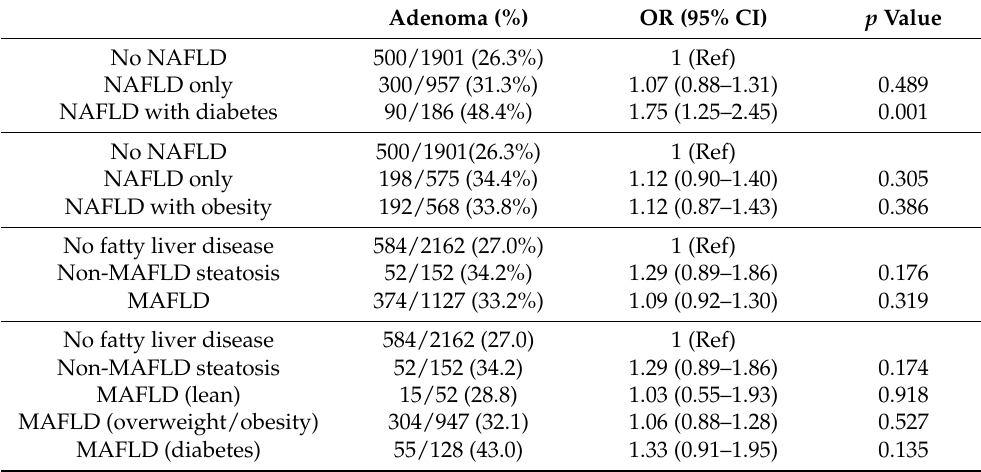
Table 4. Multivariate analyses of the risk for colorectal adenoma by NAFLD/MAFLD with diabetes or obesity.